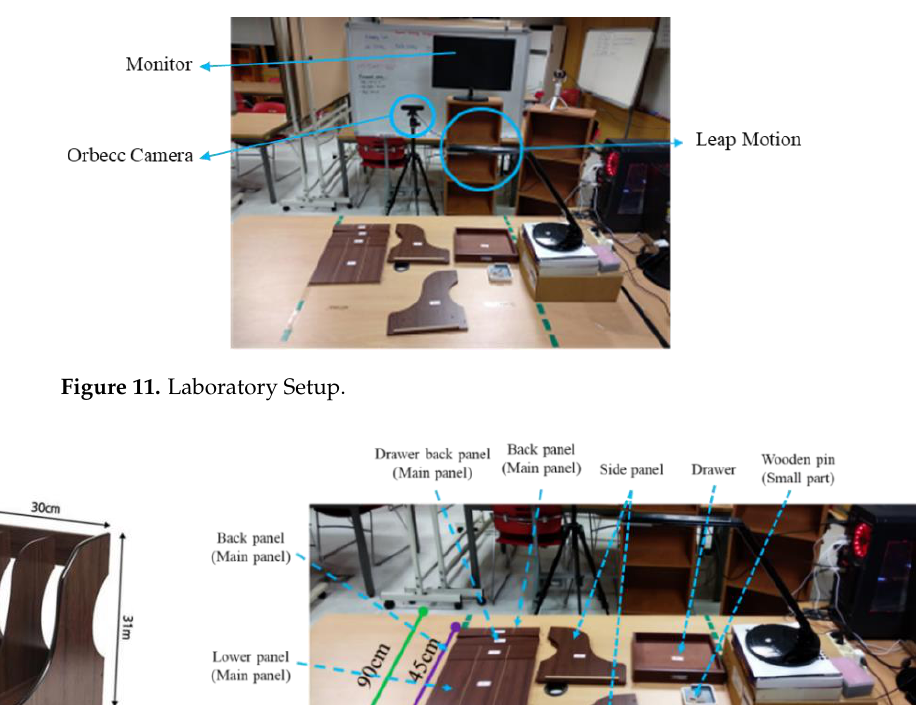
Figure 12. ( a ) Product; ( b ) Panel positioning for assembly.